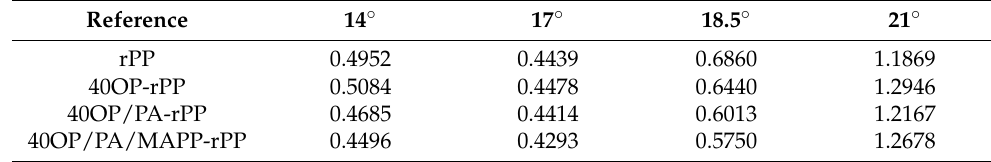
Table 7. FWHM values in the reflection peaks present in the XRD patterns of the biocomposites.